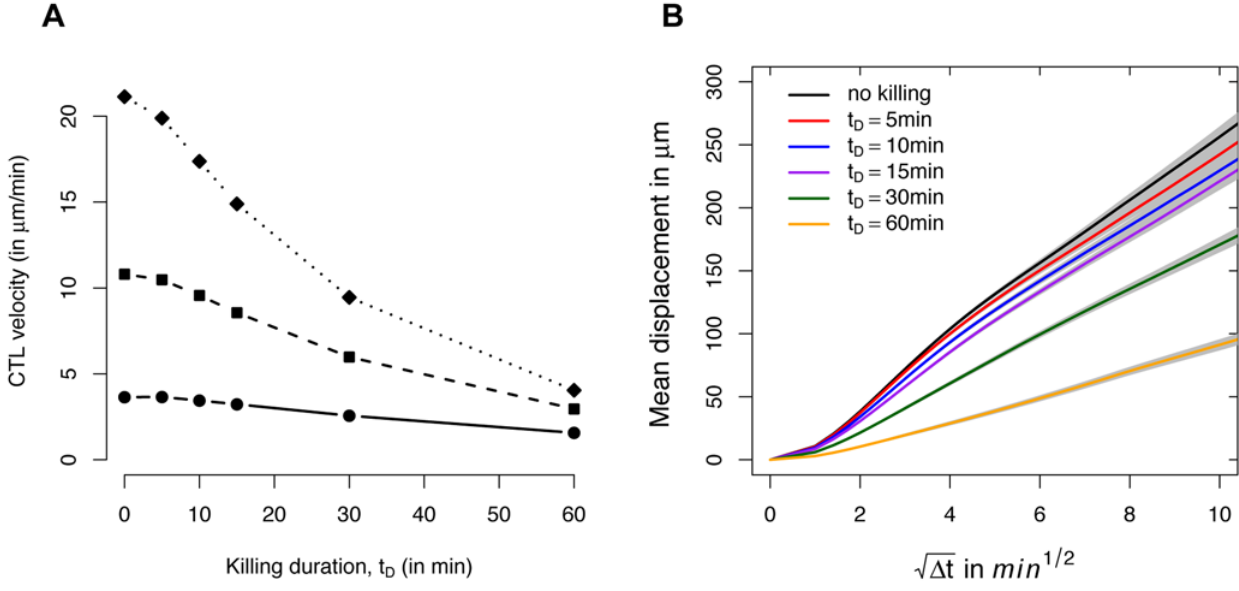
Figure 3. Changes in CTL velocity and motility due to killing activity. (A) Change in mean CTL velocity due to killing activity with different values of t D for three different starting velocities (cid:1) vv h ( 21 : 1 m m = min (diamond), 10 : 8 m m = min (square), 3 : 65 m m = min (circle)). (B) Change in mean displacement of simulated CTL with killing activity against the square root of time for different values of t D (basic value with no killing (black), t D ~ 5min (red), 10 min (blue), 15 min (purple), 30 min (green), 60 min (orange)). The CTL hunting velocity is fixed with (cid:1) vv h ~ 10 : 8 m m = min .